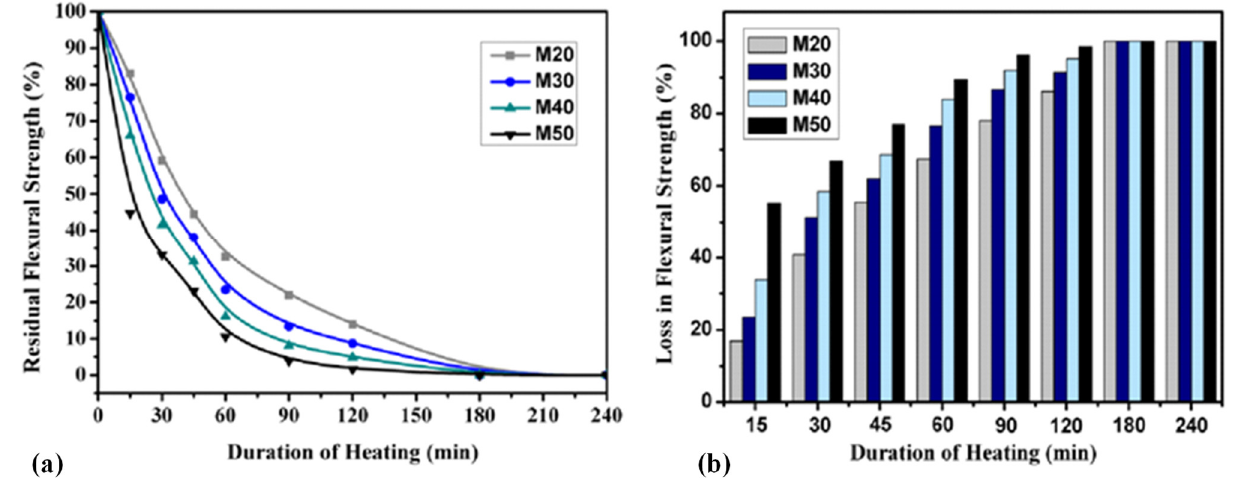
Figure 8. ( a ) Residual FS of concrete specimens, ( b ) loss of FS of concrete specimens.